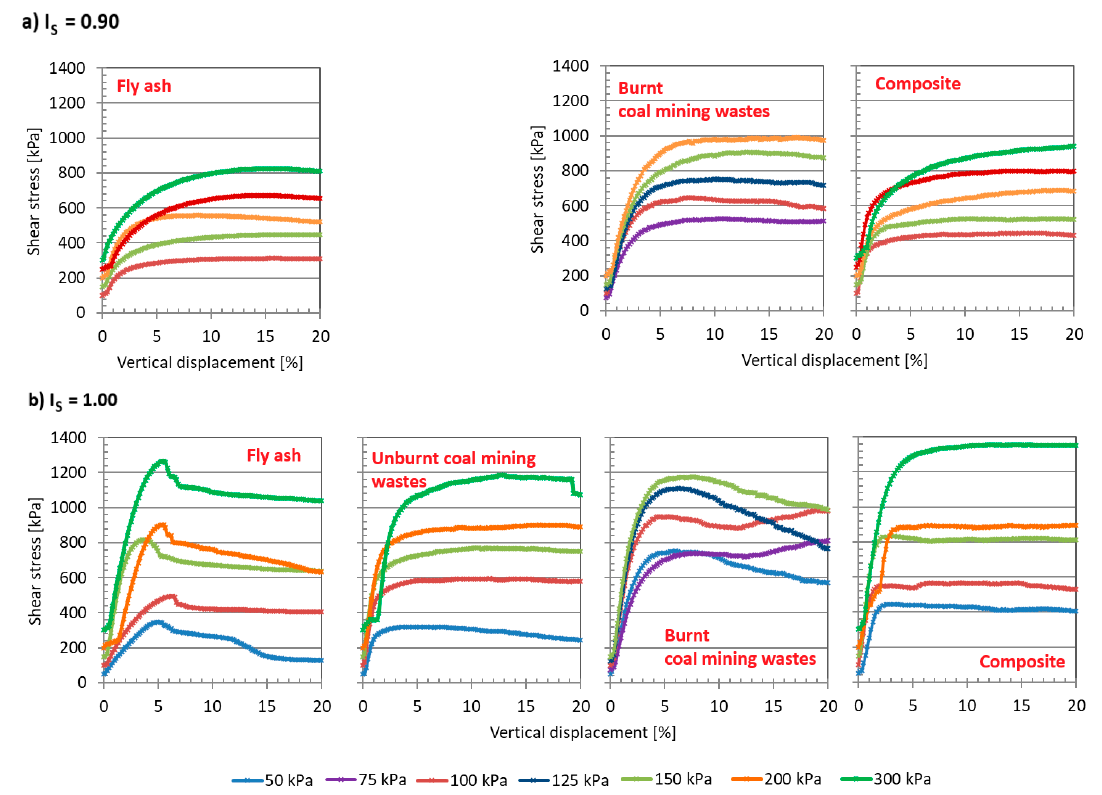
Figure 4. Changes in shear stress along with increasing axial deformation of samples.